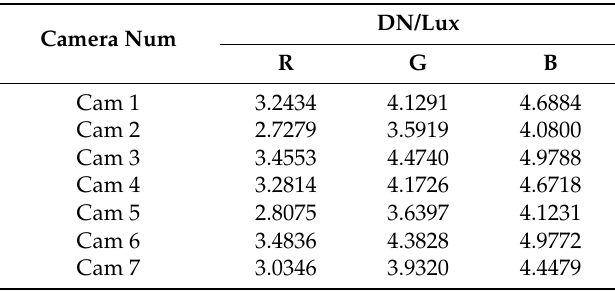
Table 2. Ratio of digital number and illuminance with 2/25 ms (1 ‐ stop) exposure time and ×1 gain setting.